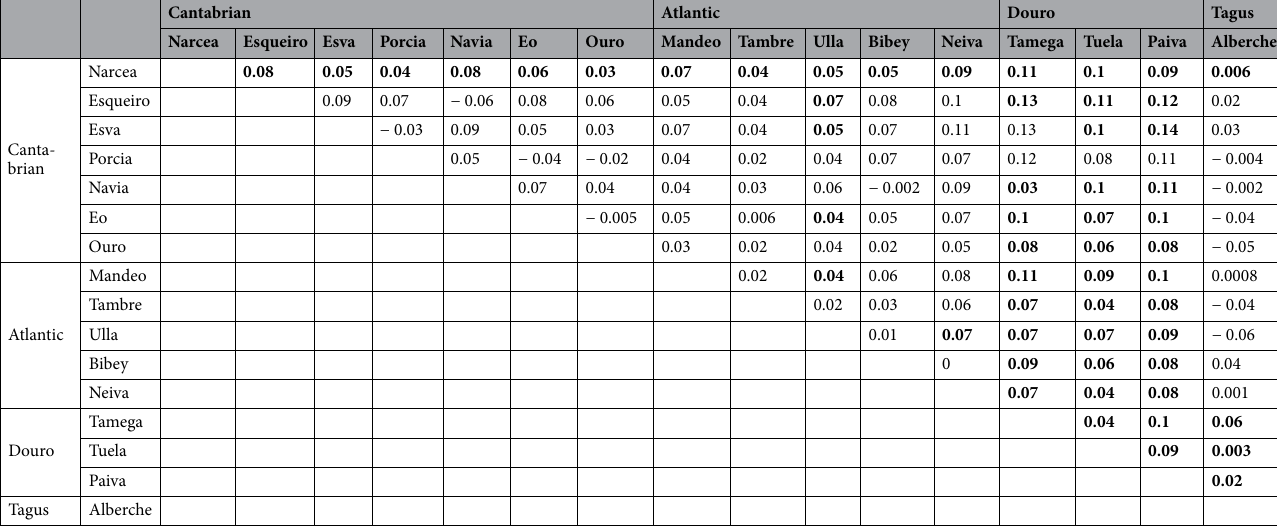
Table 2. F ST pairwise comparisons at sub-basin level based on the Weir and Cockerham’s (below diagonal) estimator. In bold significant values at 95% confidence level for the Weir and Cokerham’s estimator after Bonferroni (p-value: 0.003)